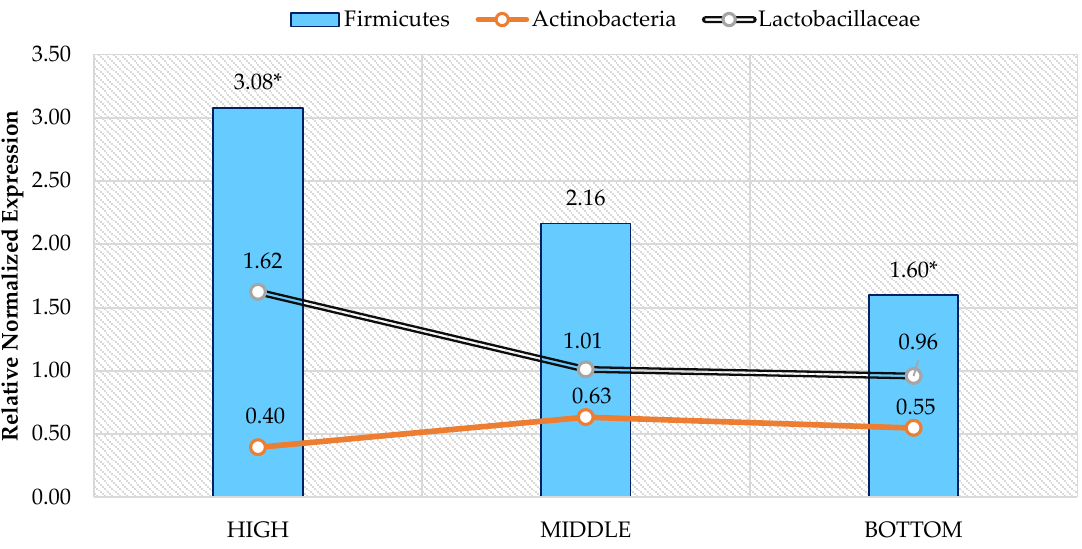
Figure 6. The level of studied phyla and families depending on the height of the cages. * p = 0.038.